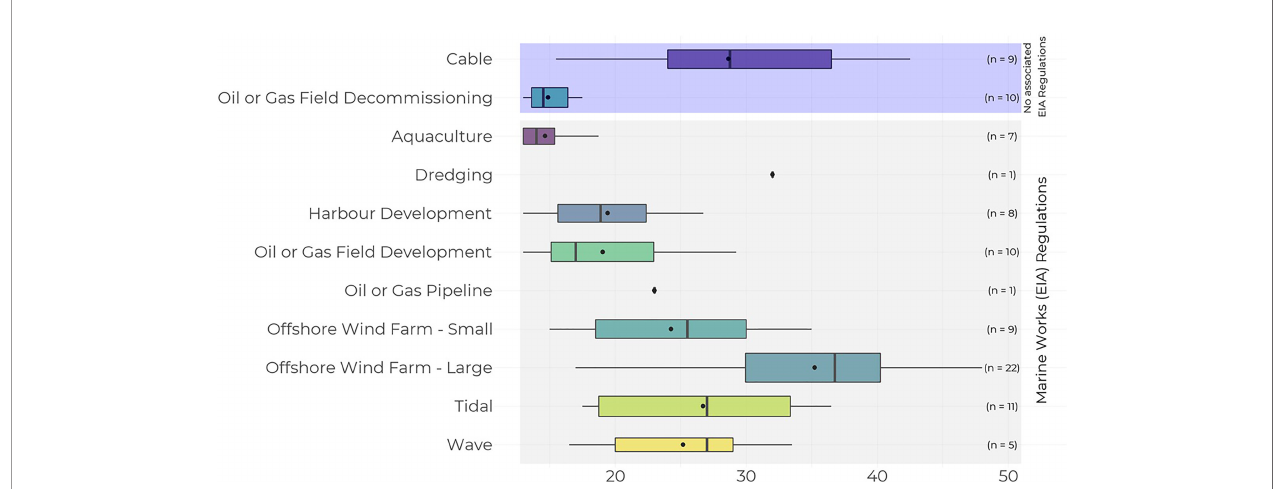
FIGURE 2 | Mean and median scores of marine mammal Cumulative Effects Assessments (CEAs) across maritime industries. Industries are grouped based on the regulations associated with the required EIA and CEA (for more detail, see Figure 1 ). The industries that fall under the Marine Works (EIA) Regulations 2017 commonly also fall under the remit of other EIA Regulations, though the policy wording via other regulations is identical, hence only presenting the Marine Works (EIA) Regulations here for clarity. The boxplot shows the median (line through box), mean (dot), and lower and upper hinges ( fi rst and third quartile). Widths of boxes are proportional to the square-roots of the number of observations (CEAs reviewed) in the groups.